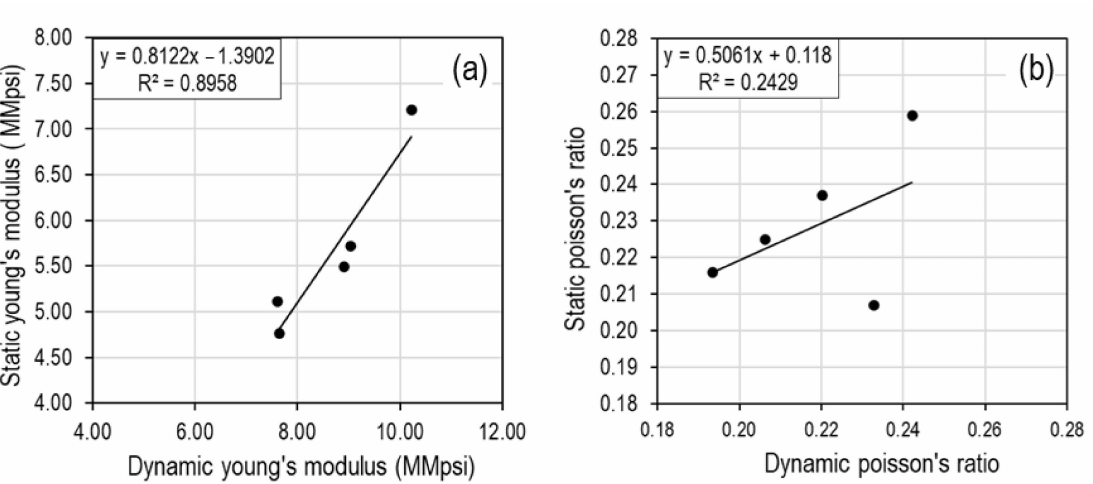
Figure 15. Relationship between dynamic and static ( a ) Young’s moduli and ( b ) Poisson’s ratio.